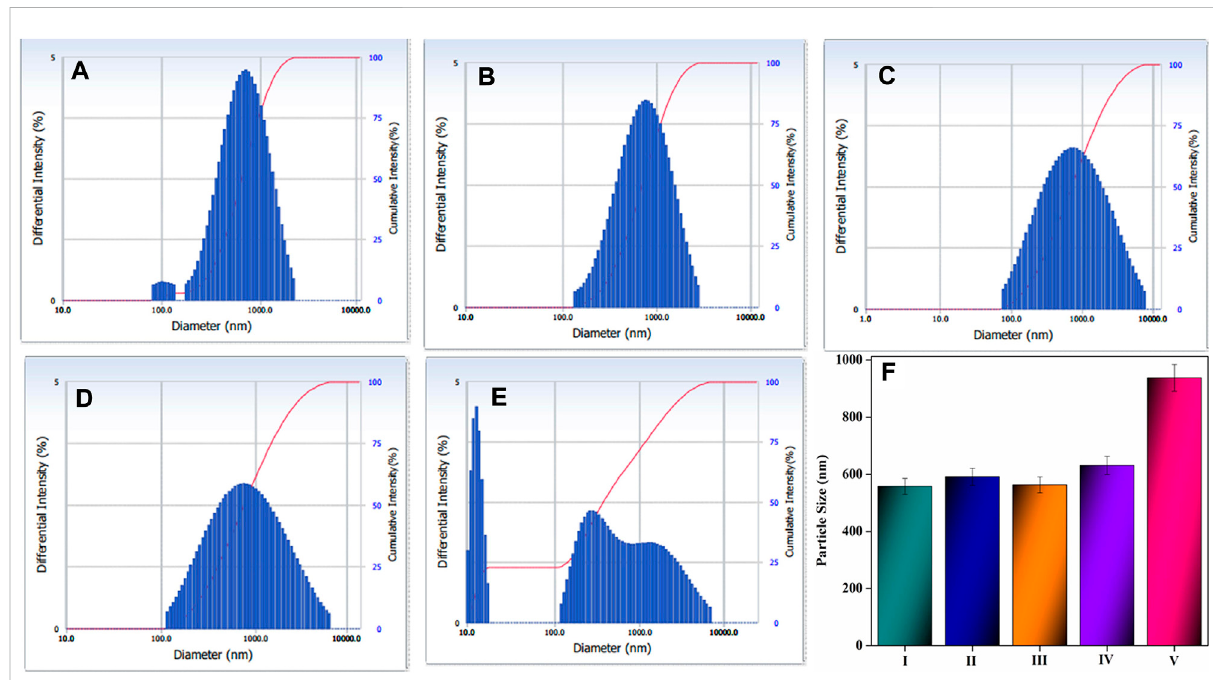
FIGURE 5 Particle size distribution curve of (A) pure HAP ceramic, (B) pure CCQD, (C) HAP/COL composite, (D) HAP/COL/CCQD composite, (E) HAP/ COL/CCQD/CRN composite and (F) bar diagram represents the cumulant particle size of all composites including (I) pure HAP ceramic (II)